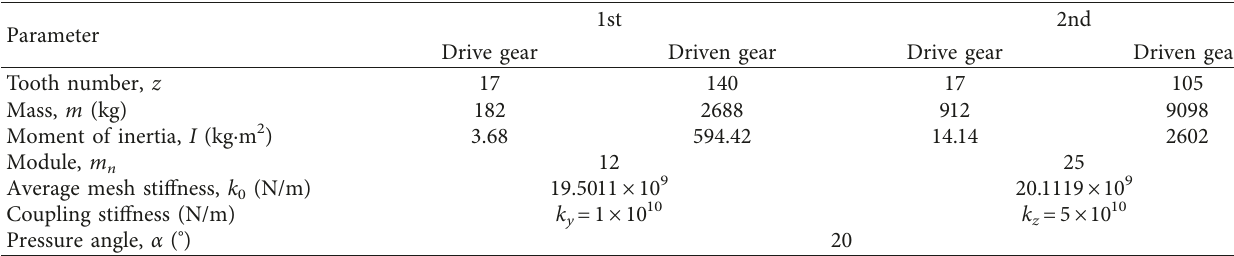
Table 2: Transmission parameters of gear subsystem.